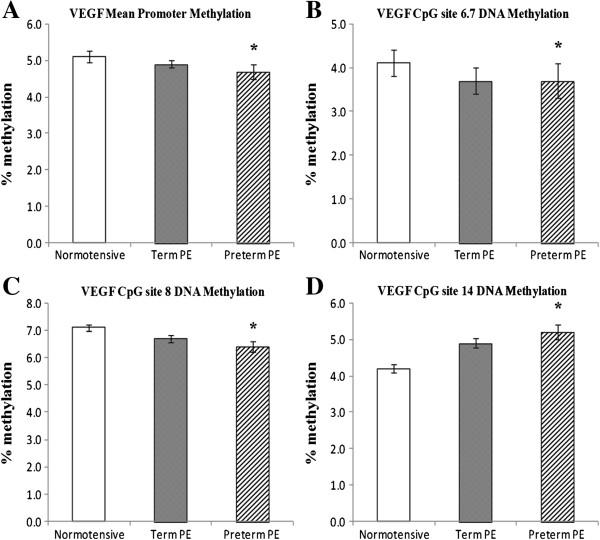
Mean promoter methylation levels and differentially methylated sites in the VEGF promoter: (A) VEGF Mean Promoter; (B) VEGF CpG site 6.7; (C) VEGF CpG site 8; (D) VEGF CpG site 14. *P <0.05 compared to normotensive group. PE, preeclampsia.